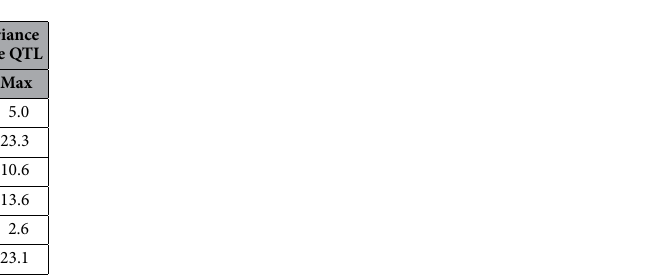
Figure 2. –log 10 ( P ) values of the effects of variants on milk mineral (Ca, P, Mg, K, and Na) or citrate content plotted against their position on Bos taurus autosomes 1 and 20.